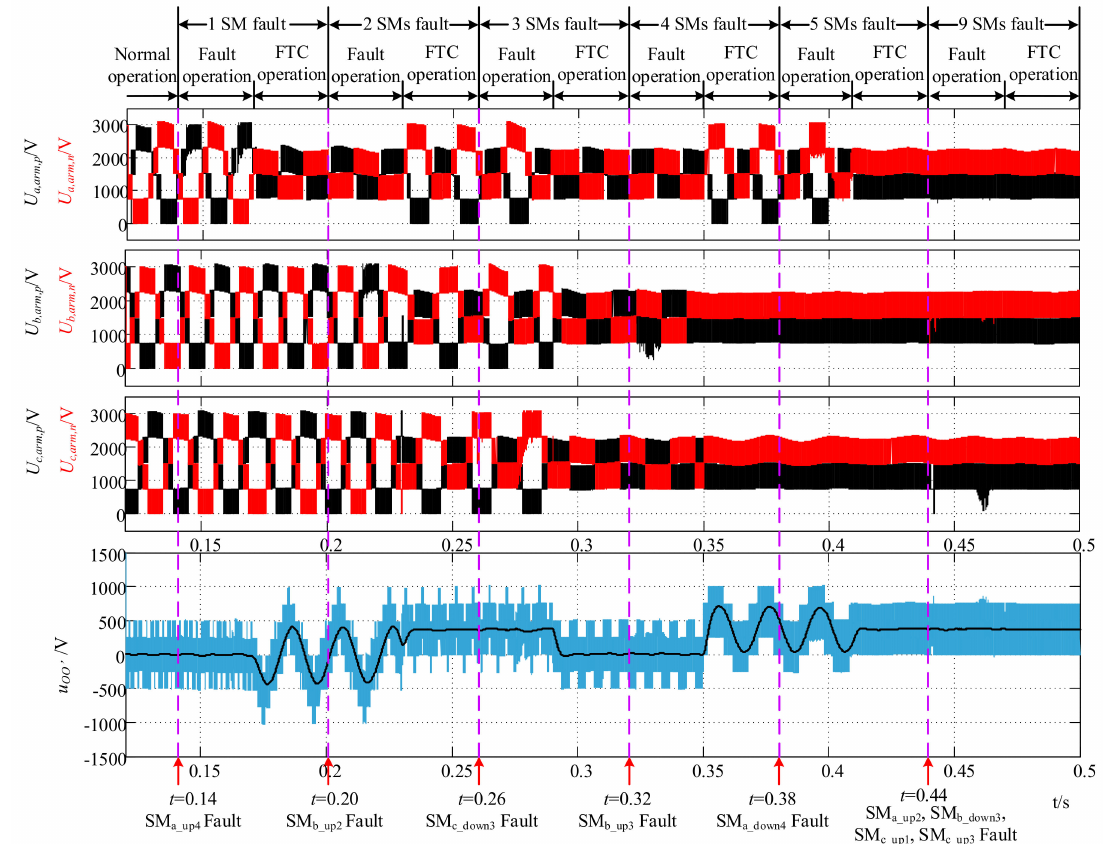
Figure 10. The three-phase bridge arm voltage and neutral point shift voltage